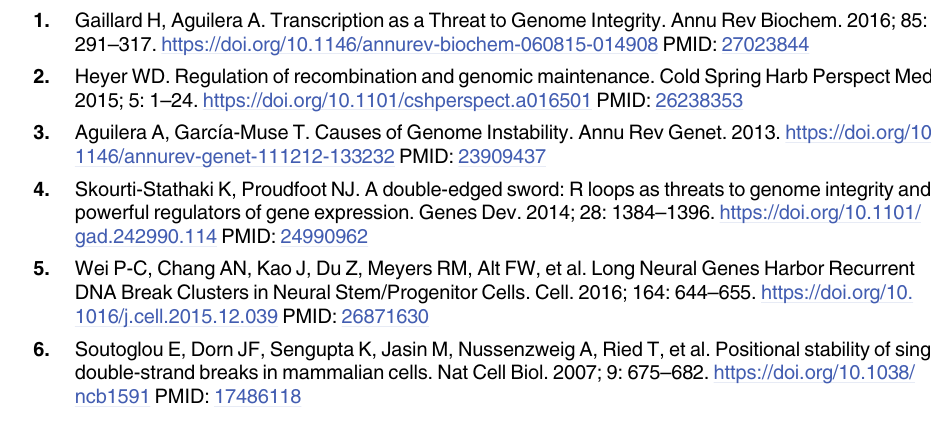
S1 Table. Probes used for FISH